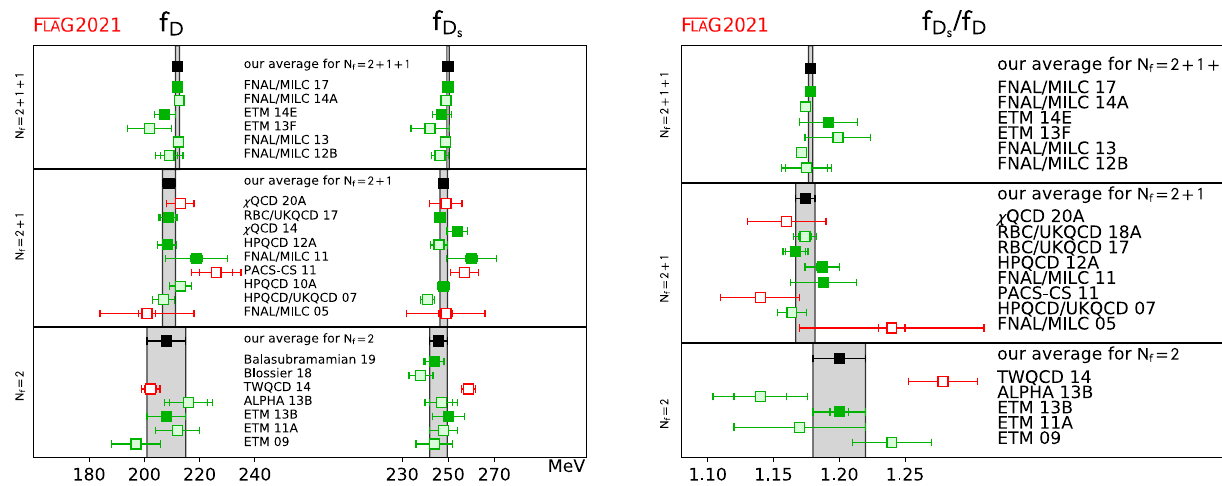
Fig. 22 Decay constants of the D and D s mesons [values in Table 34 and Eqs. (171–179)]. As usual, full green squares are used in the averaging procedure, pale green squares have been superseded by later determinations, while pale red squares do not satisfy the criteria. The black squares and grey bands indicate our